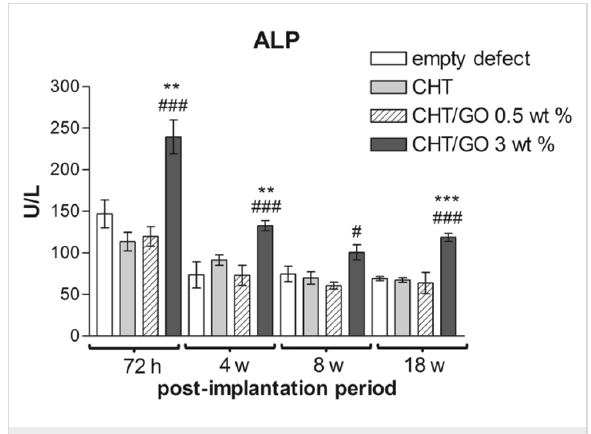
Figure 7: Alkaline phosphatase activity in mice calvaria defects implanted with chitosan containing graphene oxide nanomaterials after 7 h, 4 weeks, 8 weeks, and 18 weeks post-implantation. Figure 7 was reproduced from [120], (© 2017 A. Hermenean et al., published by Springer Nature, distributed under the terms of the Creative Commons Attribution 4.0 International License, https://creativecommons.org/